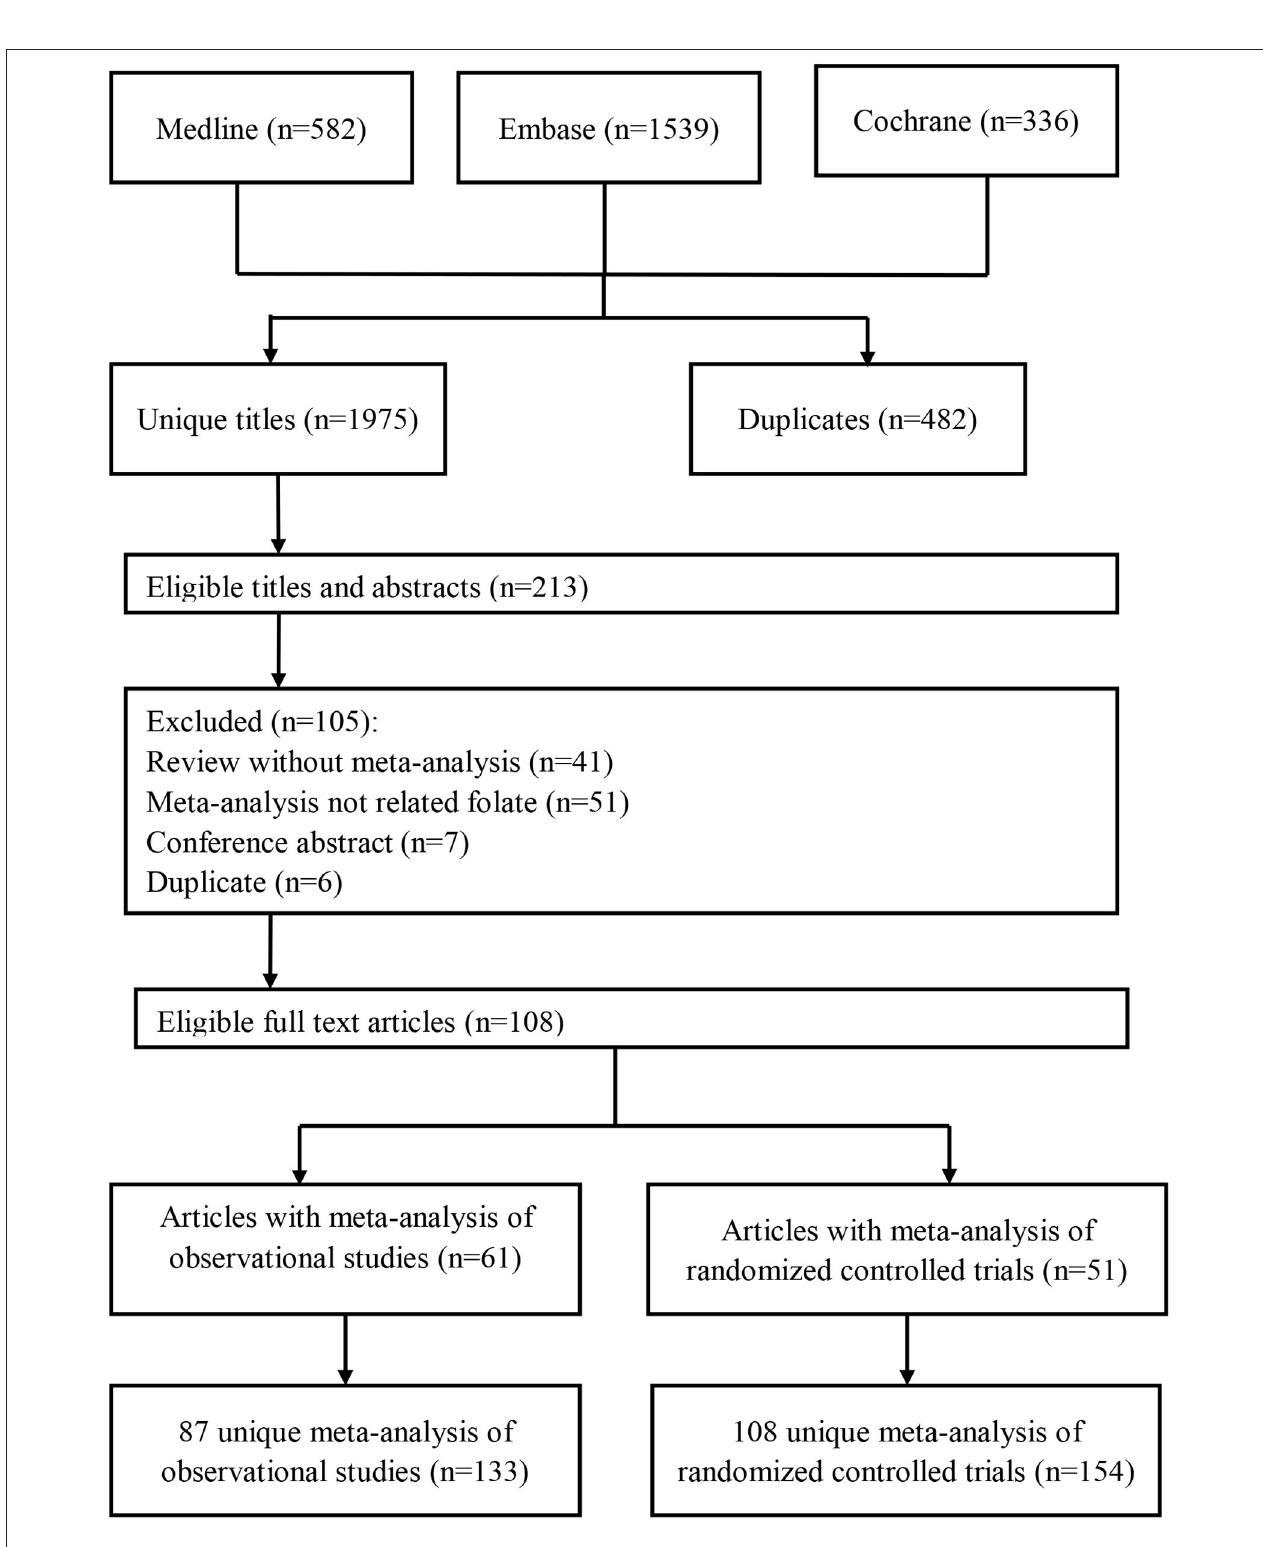
FIGURE 1 | Flowchart of selection of studies for inclusion in umbrella review on folate and health.